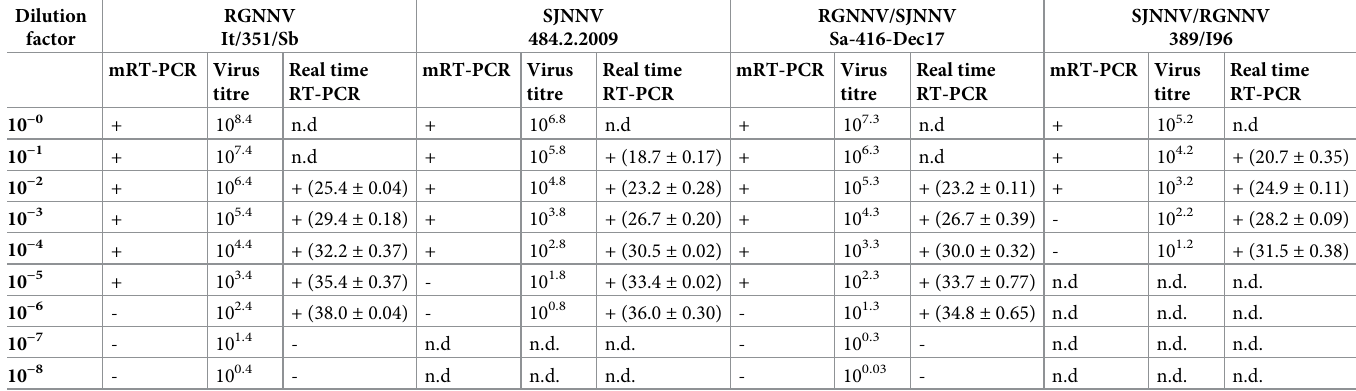
Table 2. Limit of detection of mRT-PCR determined on tenfold dilution of viral solutions; the titre is expressed as TCID 50 ml -1 ; the real time RT-PCR results are expressed as Ct values ± standard deviation (SD). Dilution factor